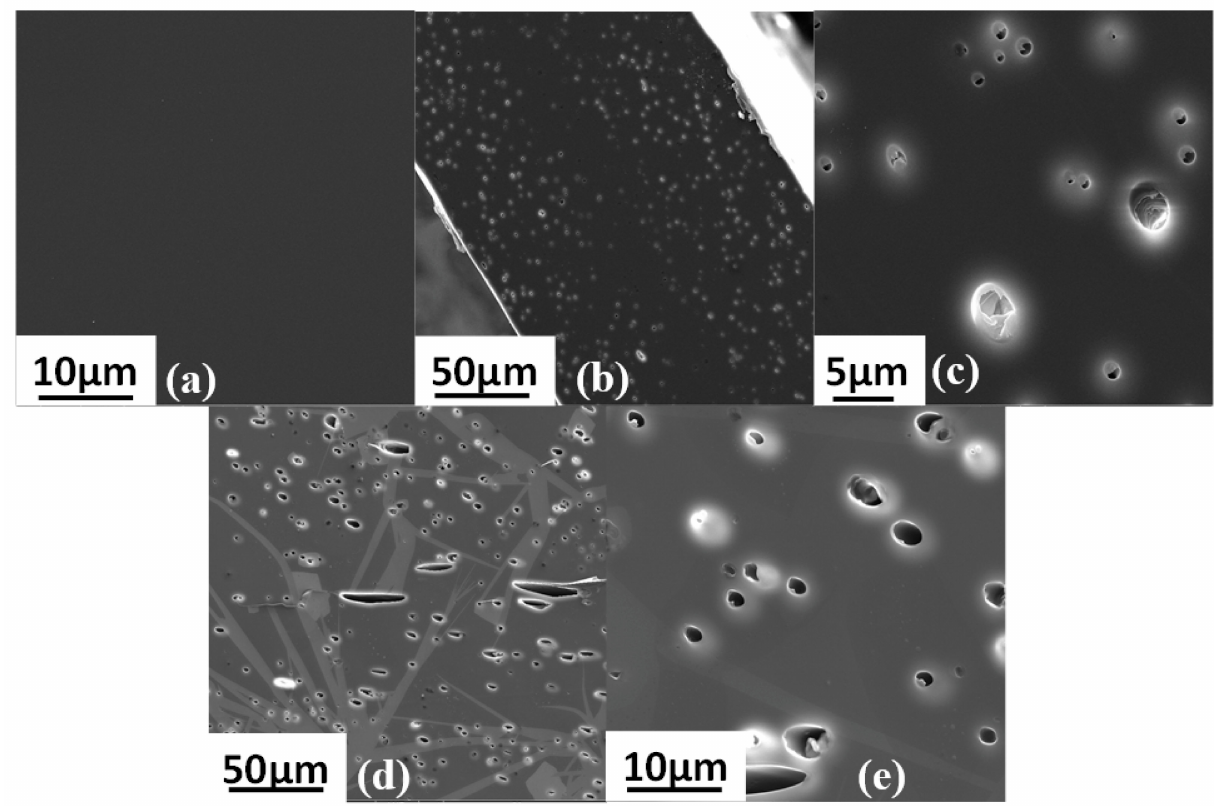
Figure 3. SEM images for the cross section morphologies of ( a ) neat PEI, ( b , c ) PEI/2.5 IL membranes and ( d , e ) PEI/7 IL membranes.